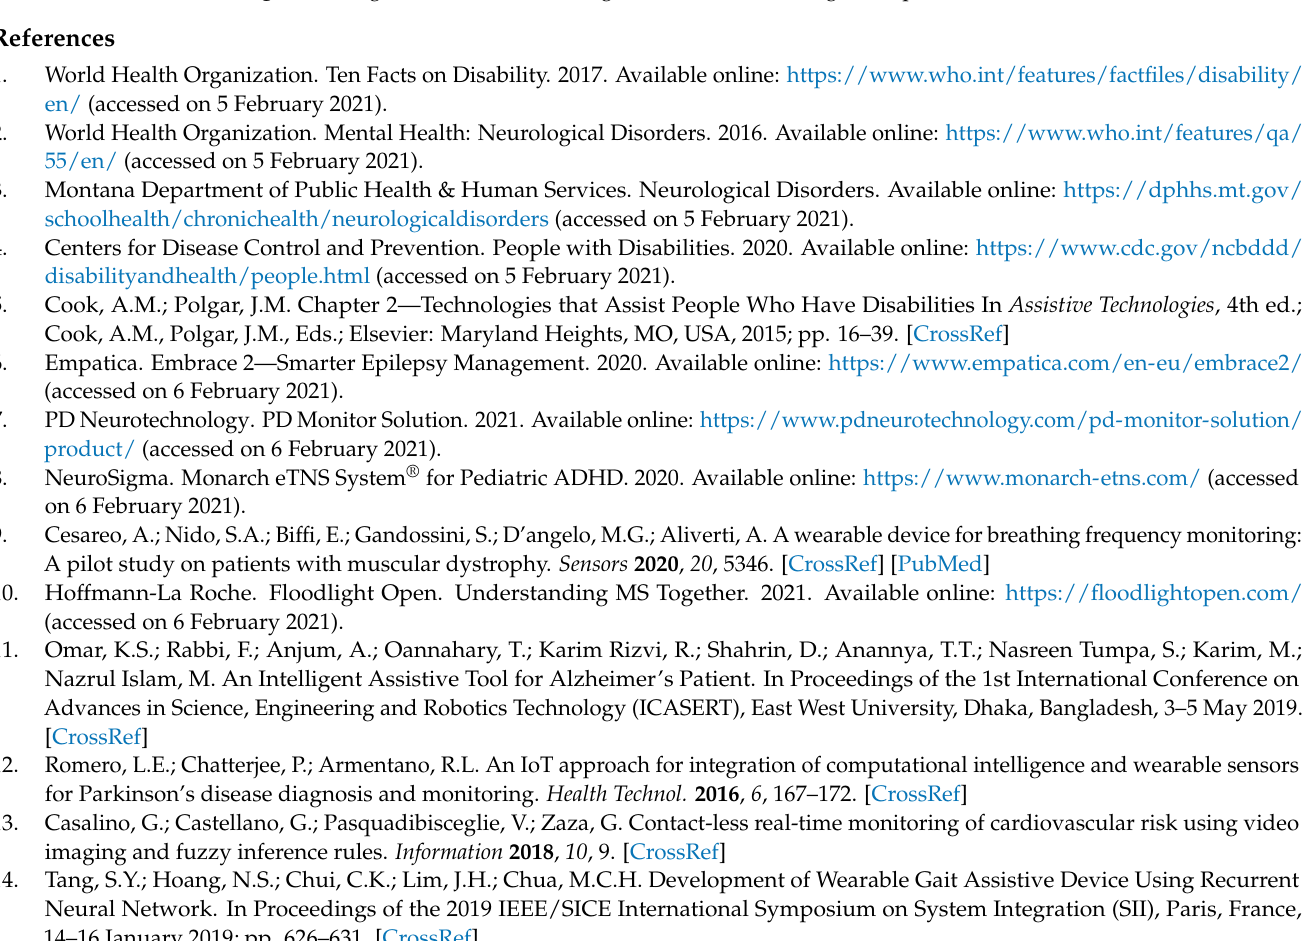
Figure 1. Fragment of the selected signals as features during the